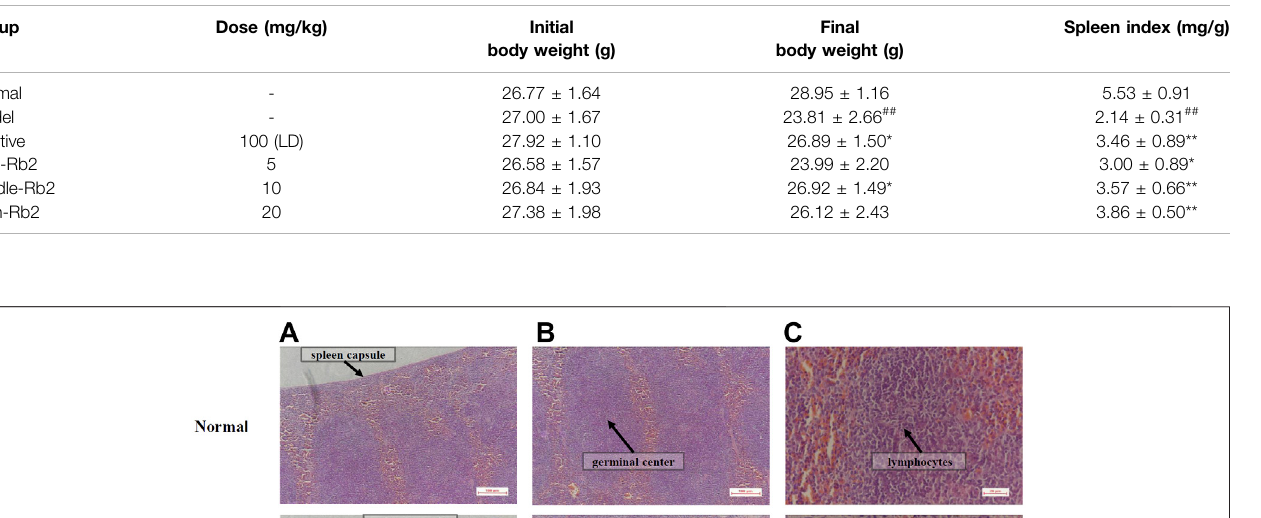
TABLE 2 | Effect of ginsenoside Rb2 on body weight and spleen indices in mice (mean ± S.D., n = 10). Group Dose (mg/kg) Initial